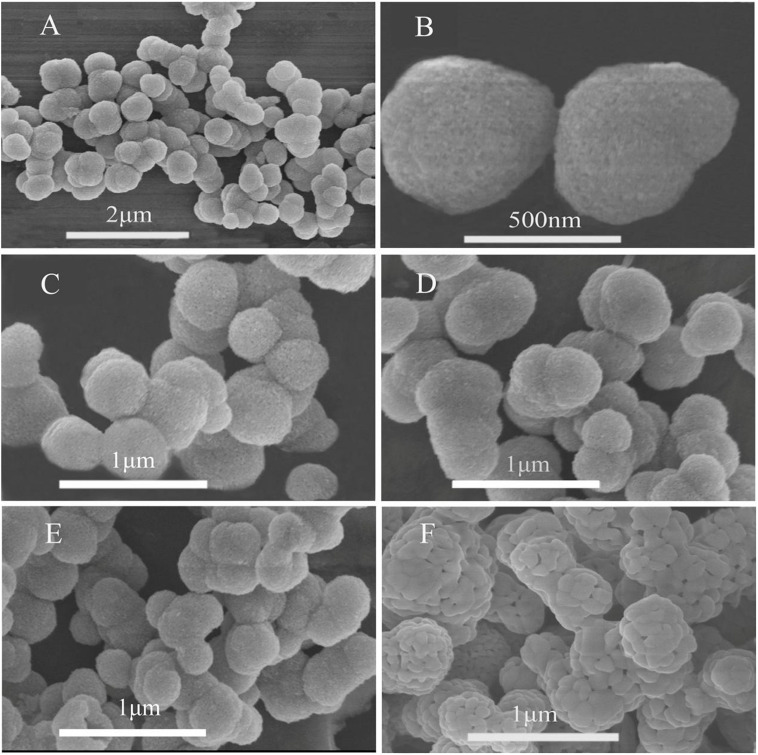
Scanning electron microscopy (SEM) micrograph of (A) α-Fe2O3-pre, (B) α-Fe2O3-pre (amplification), (C) α-Fe2O3-300, (D) α-Fe2O3-400, (E) α-Fe2O3-500, and (F) α-Fe2O3-600.